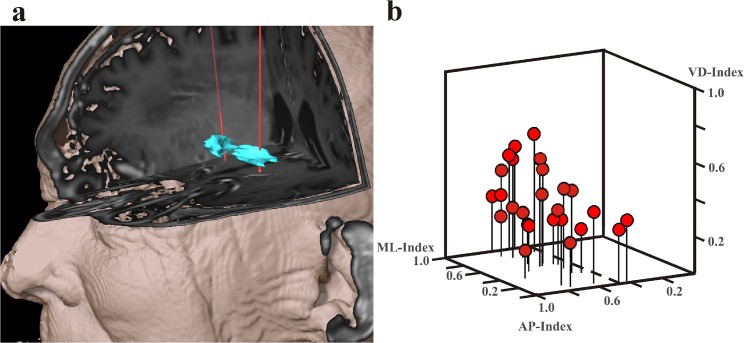
Reconstruction of the implanted DBS leads and 3D-scatterplot of the actice contact position.A: Reconstruction of DBS leads of a patient with bilateral DBS demonstrates lead location in the posterior part of the GPi. B: 3D-scatterplot of the actice contact position (red dots) relative to the border of the GPi. Position of the vast majority of the active contacts is in the posterior (AP-Index > 0.5) and ventral (VD-Index < 0.5) part of the GPi.